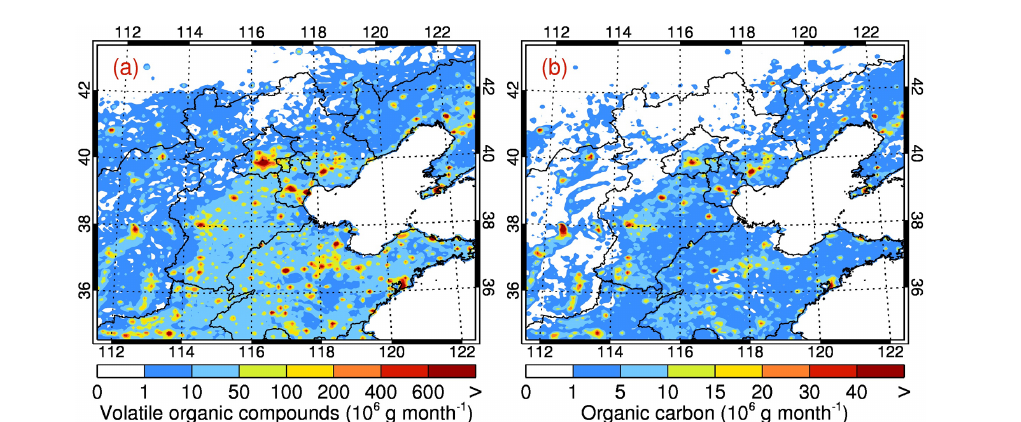
Figure 2. Geographic distributions of anthropogenic emissions of (a) volatile organic compounds and (b) organic carbon in October in the simulation domain. The black lines present provincial boundaries in